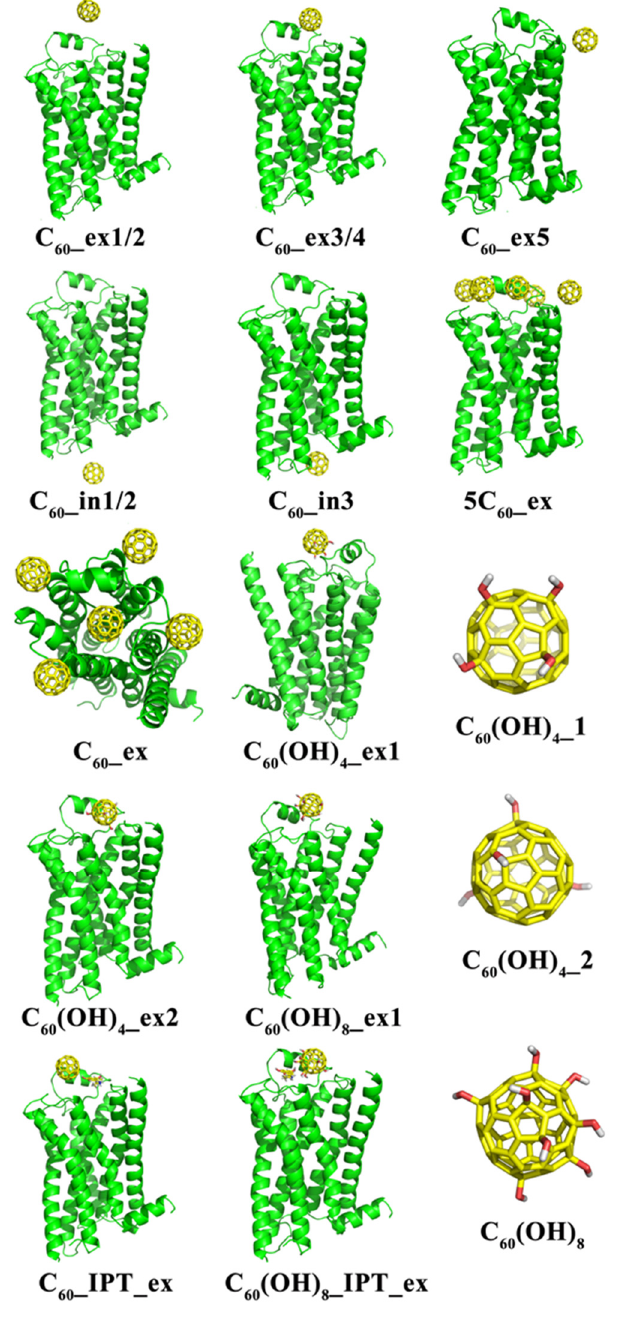
Figure 2. The initial structures of the fullerene derivatives C 60 (OH) 4 _1, C 60 (OH) 4 _2 and C 60 (OH) 8 for simulation. for